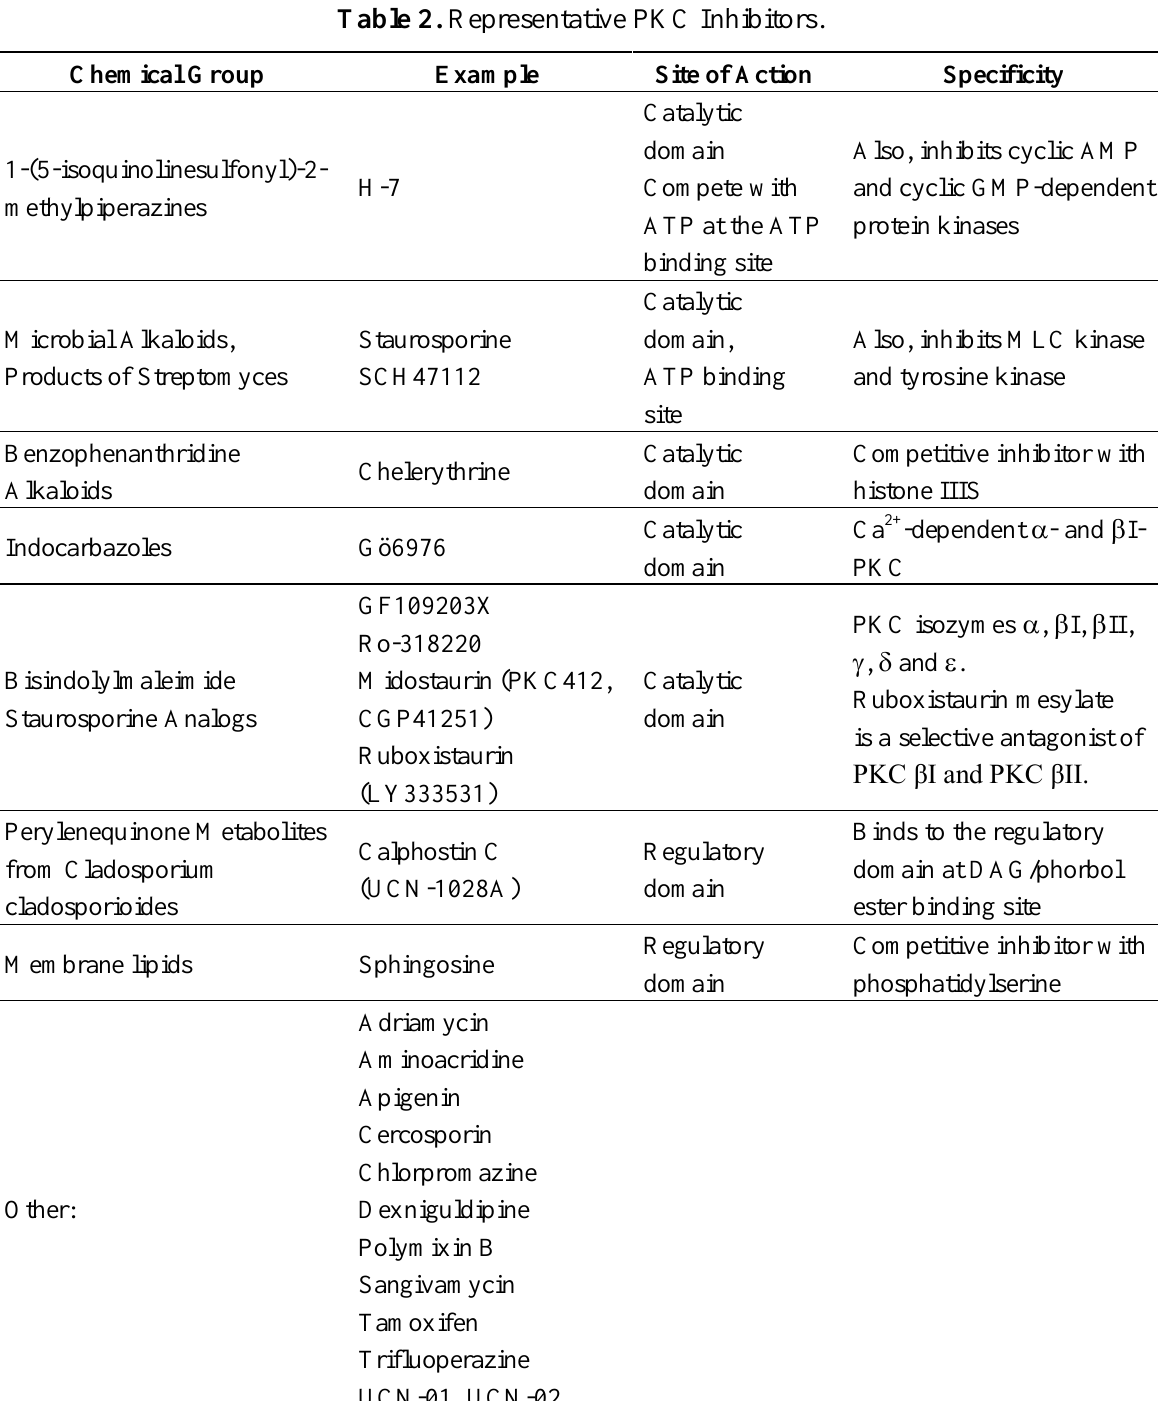
Table 2. Representative PKC